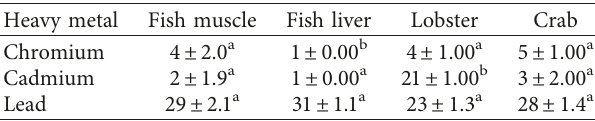
Table 3: Mean ( ± SD) concentration of heavy metals (mg/kg) in the different